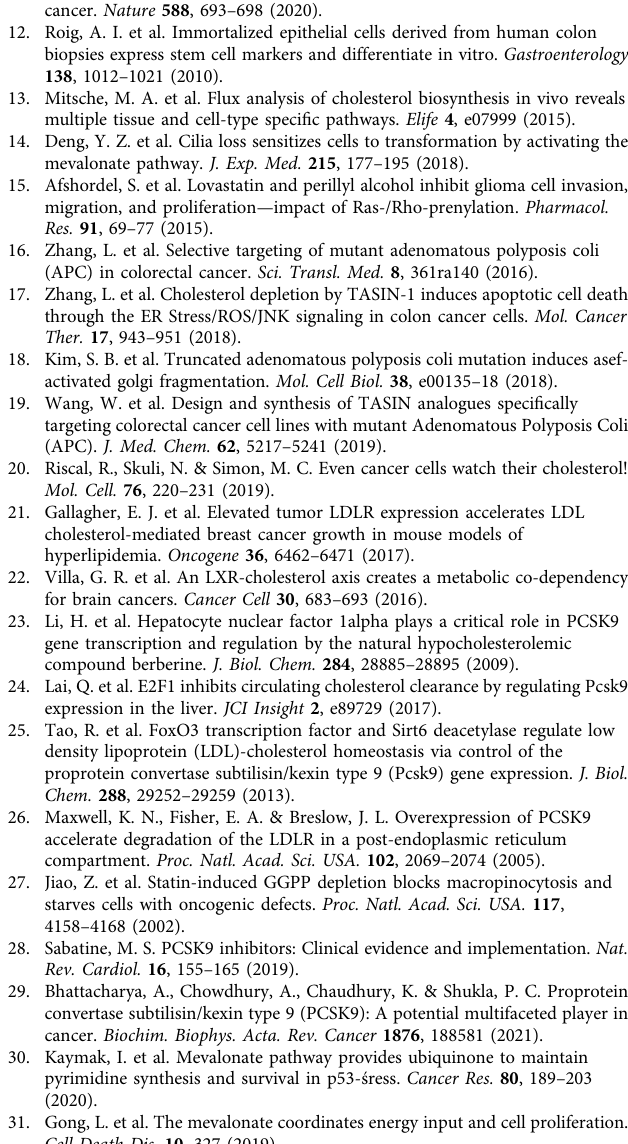
Fig. 6 PCSK9 and simvastatin synergistically inhibited APC / KRAS -mutant CRC growth and clinical signi fi cance of PCSK9 in CRC. A Nude mice harboring SW1116 xenografts were treated with vehicle (PBS), R-IMPP (100 mg/kg), or PF-06446846 (50 mg/kg) ( n = 1 experiment, n = 5 mice per group) by intraperitoneal injection every 2 days. Both R-IMPP and PF-06446846 inhibited tumor growth. B si PCSK9 synergized with simvastatin to inhibit cell growth and induce apoptosis of 1CT-AK cells ( n = 3, 72 h). C Evolocumab synergized with simvastatin to promote cell apoptosis in KRAS-mutant CRC cells (96 h). D The co-administration of R-IMPP or PF-0644846 reduced 48 h-IC 50 of simvastatin in KRAS-mutant CRC cells ( left ) ( n = 3). Isobologram analyses indicated that combination of R-IMPP or PF-0644846 plus simvastatin were synergistic in suppressing cell viability ( right ). E Nude mice harboring SW1116 xenografts were treated with vehicle, R-IMPP, simvastatin, or their combination ( n = 1 experiment, n = 5 mice per group). The combination drug treatment induced tumor regression and signi fi cantly suppressed tumor weight, PCSK9 protein expression and GGPP levels compared to vehicle or single treatment. F PCSK9 mRNA is up-regulated in CRC tissues as compared with paired adjacent normal tissues in Hong Kong ( n = 150 pairs), and TCGA cohorts ( n = 50 pairs), and in unpaired samples from TCGA cohort ( n = 675). G PCSK9 protein expression is increased in CRC compared to adjacent normal tissues assessed by western blot. H Tissue microarray cohort ( n = 137) showed that PCSK9 protein expression predicts poor survival of APC MUT KRAS MUT CRC ( n = 66), but not in APC MUT KRAS WT CRC ( n = 71) or overall cohort. Log-rank test (two-tailed). I PCSK9 mRNA predicts poor patient survival in APC MUT KRAS MUT CRC ( n = 162) in TCGA cohort, but not in APC MUT KRAS WT CRC ( n = 206) or overall cohort ( n = 368). Log-rank test (two-tailed). J Multivariate COX proportional hazards regression analysis of the prognostic value of PCSK9 in APC MUT KRAS MUT CRC patients in both Hong Kong and TCGA cohorts ( n = 162, biological replicates). COX proportional hazards regression analysis. Data shown are means of biological replicates; ± SEM ( A – F ). Two-tailed Student ’ s t -test ( A , E , F ). Two-tailed two-way ANOVA for growth curves ( A , E ). Source data are provided as a Source Data fi